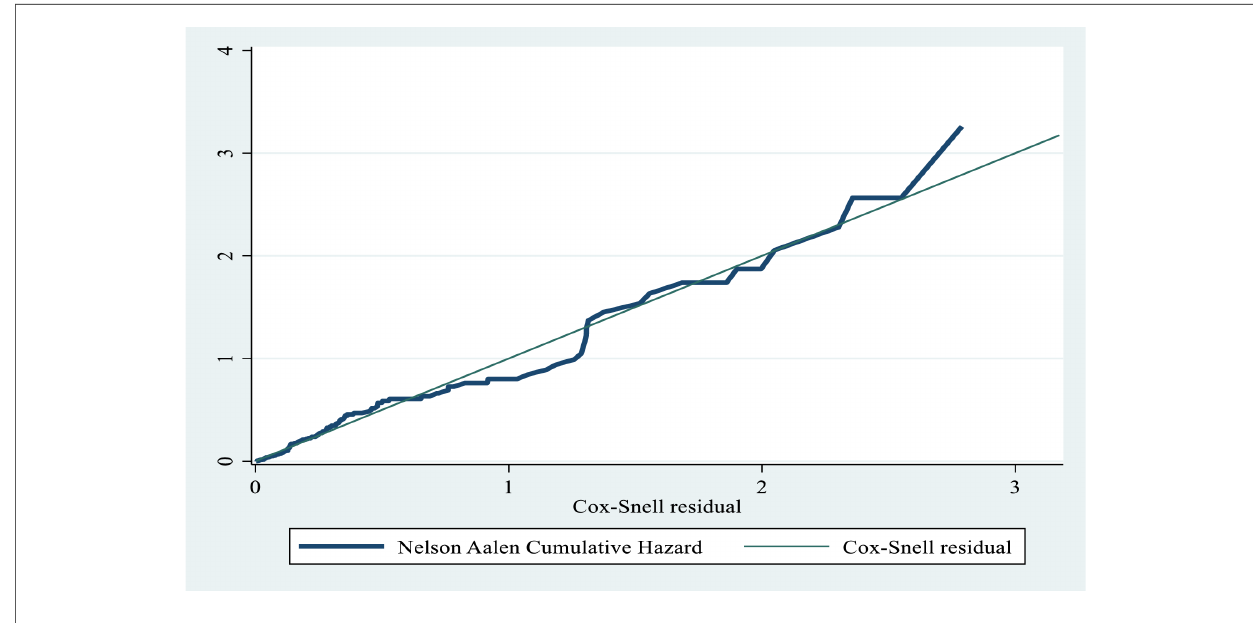
FIGURE 2 Goodness-of- fi t test for the Cox proportional hazard regression